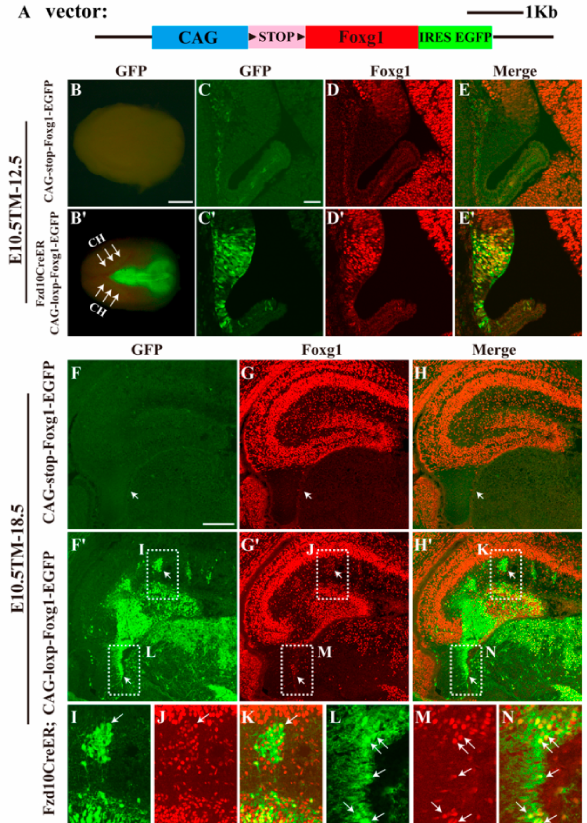
Figure 1. Forced expression of Foxg1 in the cortical hem and abnormal development of the dentate gyrus. ( A ) Schematic representation of the construction of the transgenic vector. ( B , B (cid:48) ) Dorsal view of an E12.5 Fzd10CreER TM ;CAG-loxp-Foxg1-IRES-EGFP hemisphere after E10.5 TM-induction. Reporter EGFP specifically labelled the hem and the dorsal thalamus where endogenous Fzd10 is expressed. Arrows in B’ indicate the GFP-expressing cortical hem (CH). ( C – E (cid:48) ) Double immunostaining for GFP with Foxg1 at E12.5 coronal sections. In controls ( C – E ), GFP was not expressed, and Foxg1 expression is excluded from the hem, no co-localization of Foxg1 and GFP to be detected. In ( C (cid:48) – E (cid:48) ), Foxg1 was ectopically expressed in the hem and co-expressing GFP. ( F – H ) At E18.5, in the CAG-loxp-stop-loxp-Foxg1-IRES-EGFP control, no GFP was detected, and Foxg1 was expressed in both CA and DG regions but specifically excluded from the fimbria. ( F (cid:48) – H (cid:48) ) In addition to the normal DG granule cells, the expression of Foxg1 was also detected in GFP + cells. There were several clusters that were distributed outside the DG region. A mass of GFP + tissue was ectopically located at the area between the fimbria and the developing DG. ( I – N ) Magnified views of boxed areas in ( F (cid:48) – H (cid:48) ) showing the ectopic expression of Foxg1 in clusters and the fimbria. Scale bars: ( B , B (cid:48) ) 2 mm; ( C – H (cid:48) ) 200 µ m; ( I – N ) 50 µ